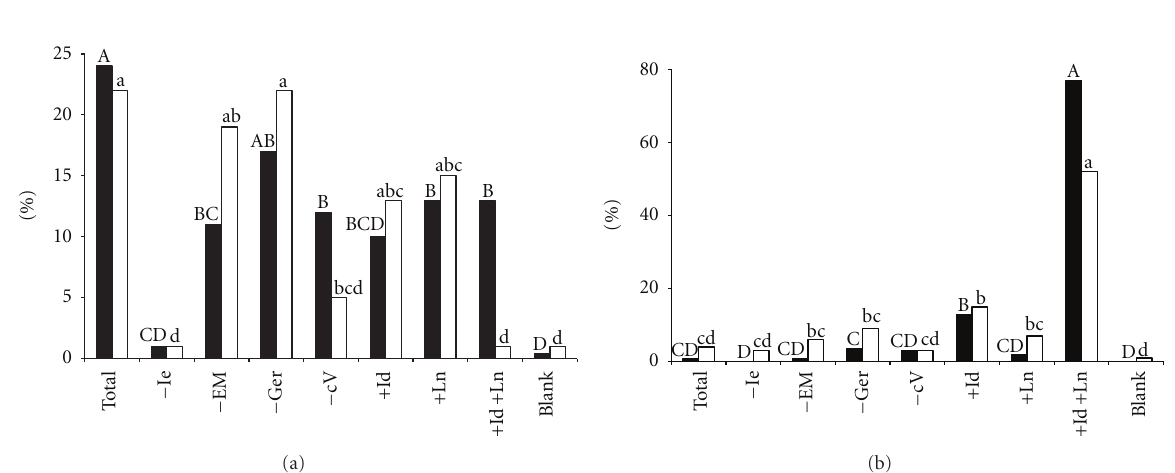
Figure 3: Percentage trap catches in a subtractive and additive field bioassay of I. grandicollis -bait: (a) I. grandicollis and (b) I. avulses, (for bait information, see Table 3). (cid:2) females; (cid:3) males. Bars with same letter are not significantly di ff erent. n = 6; total trap catches: I. grandicollis 363 ♀♀ , 235 ♂♂ ; I. avulsus 341 ♀♀ , 229 ♂♂ .